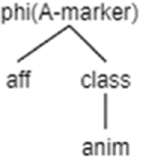
Figure 22. Geometry of the Phi label.